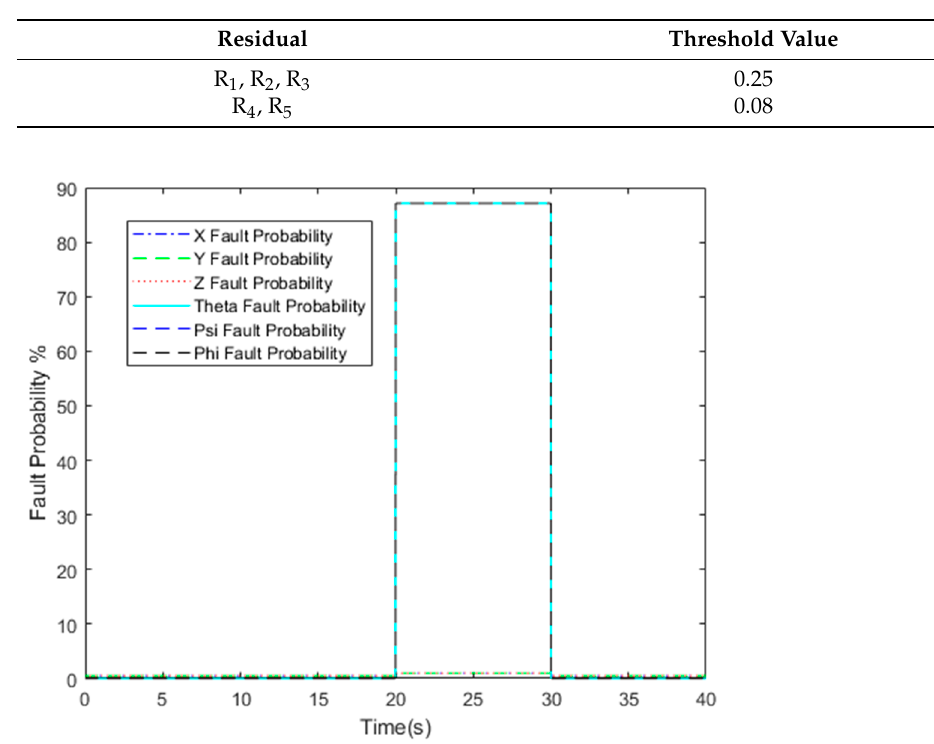
Figure 7. Bayesian fault probability (theta angle fault).